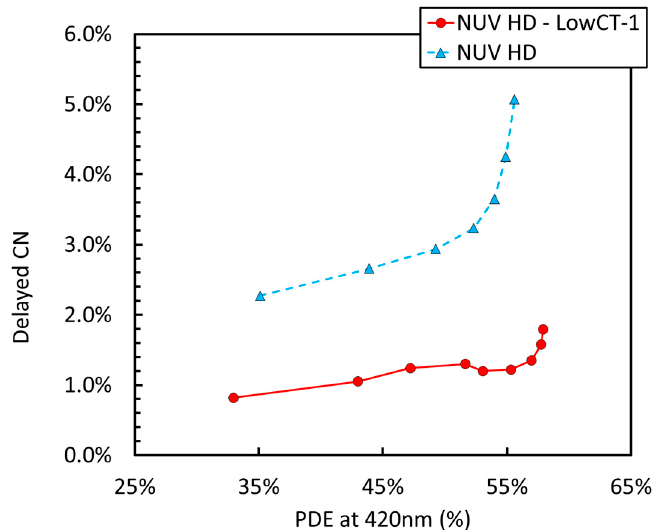
Figure 14. Probability of Delayed Correlated Noise (P DeCN ) vs. PDE at 420 nm measured on NUV-HD Figure 14 . Probability of Delayed Correlated Noise ( P DeCN ) vs. PDE at 420 nm measured on NUV- and NUV-HD-LowCT-1 with 35 µ m cell size. HD and NUV-HD-LowCT-1 with 35 µm cell size.